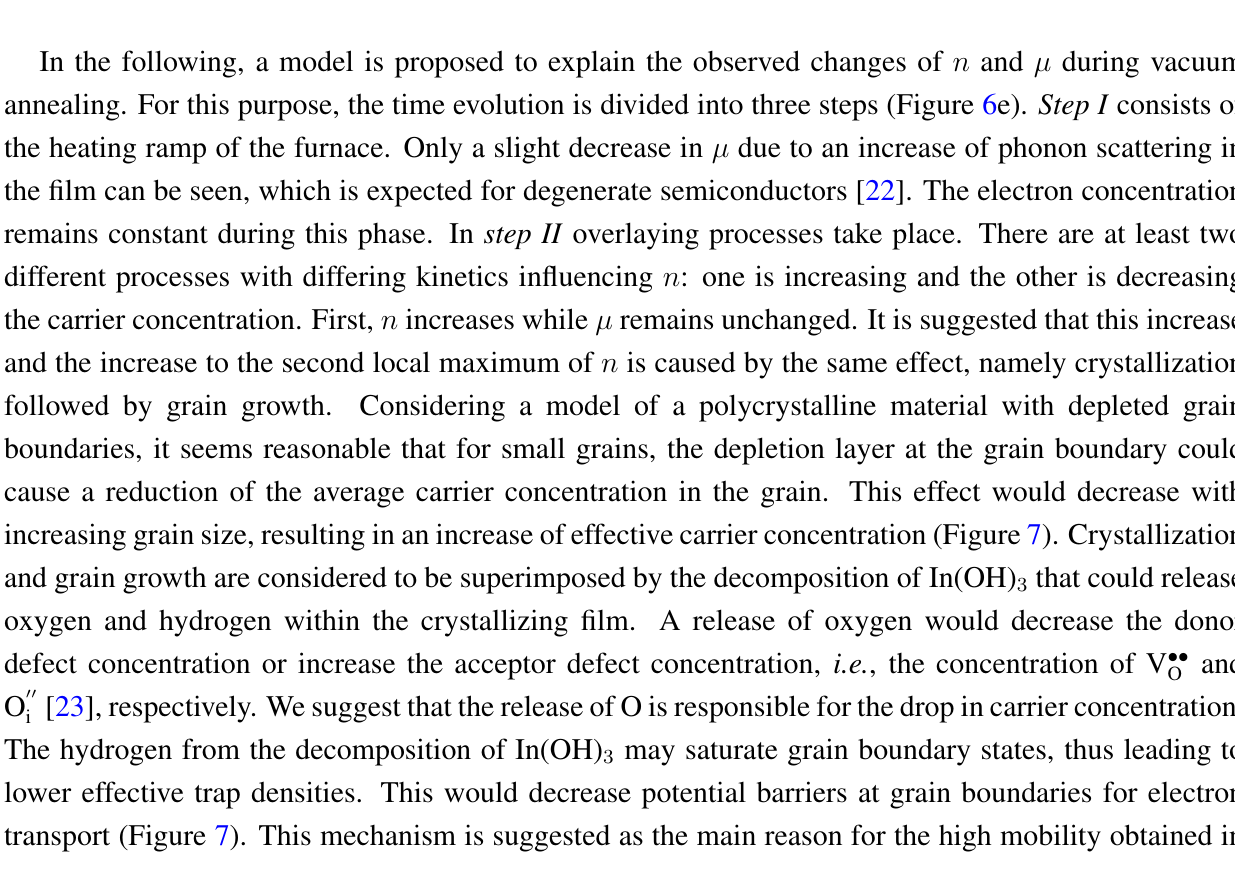
Figure 4. X-ray photoelectron spectra and fit of the O1s emission line of as-deposited In O films with varying water vapor pressure ( a ), integrated intensity ratio of O1s 2 3 shoulder-to-main emission line ( b ) and O1s emission lines of a film deposited with 1 . 0 × 10 − 3 Pa H O before and after annealing in vacuum ( c 2